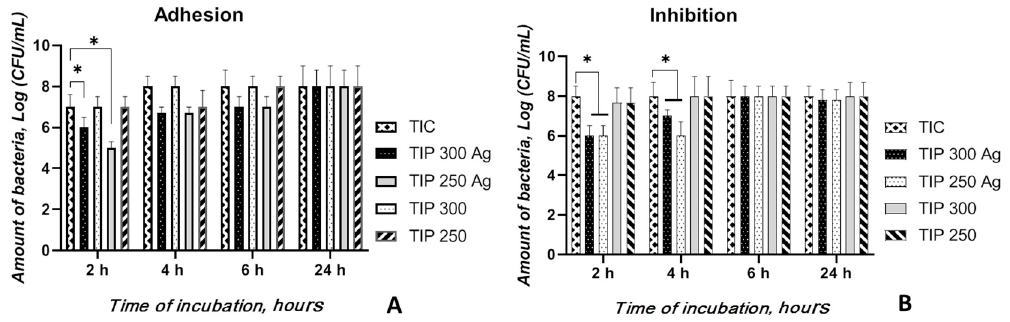
Figure 5. The number of viable bacteria adhered on the sample surfaces at different time points of the experiment ( A ) and the antibacterial activity of the samples by the inhibition assay ( B ). * A significant difference among the samples ( p < 0.05).